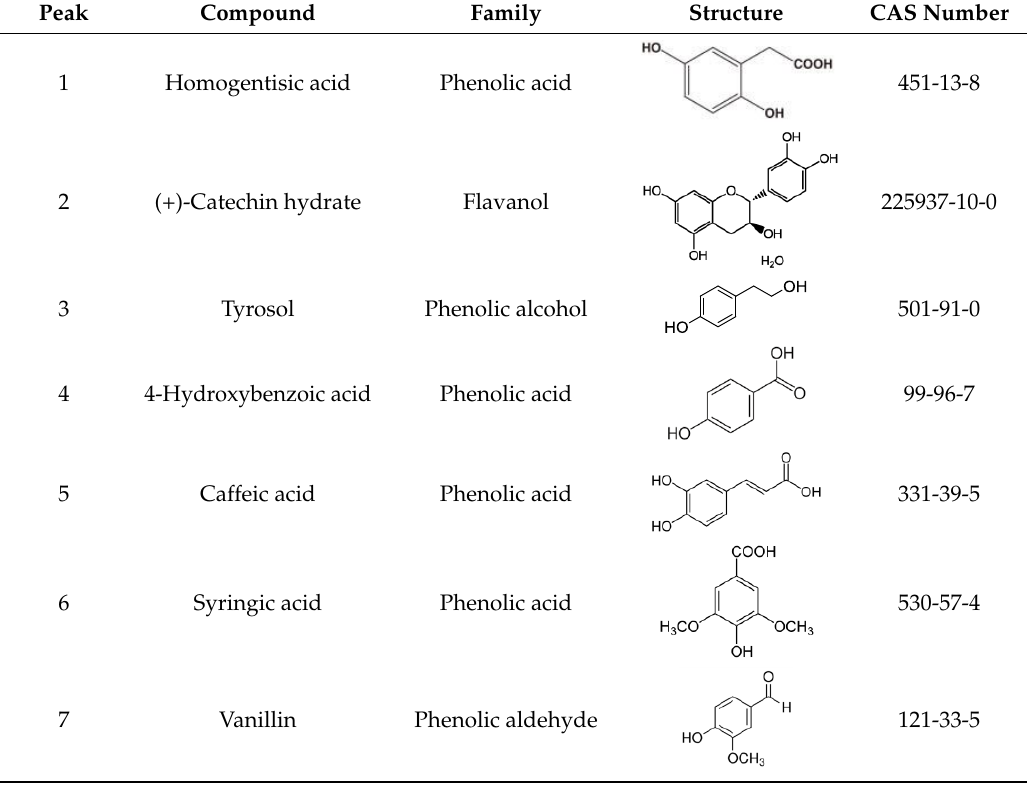
Table 1. Chemical structures of studied polyphenols and phenolic acids.